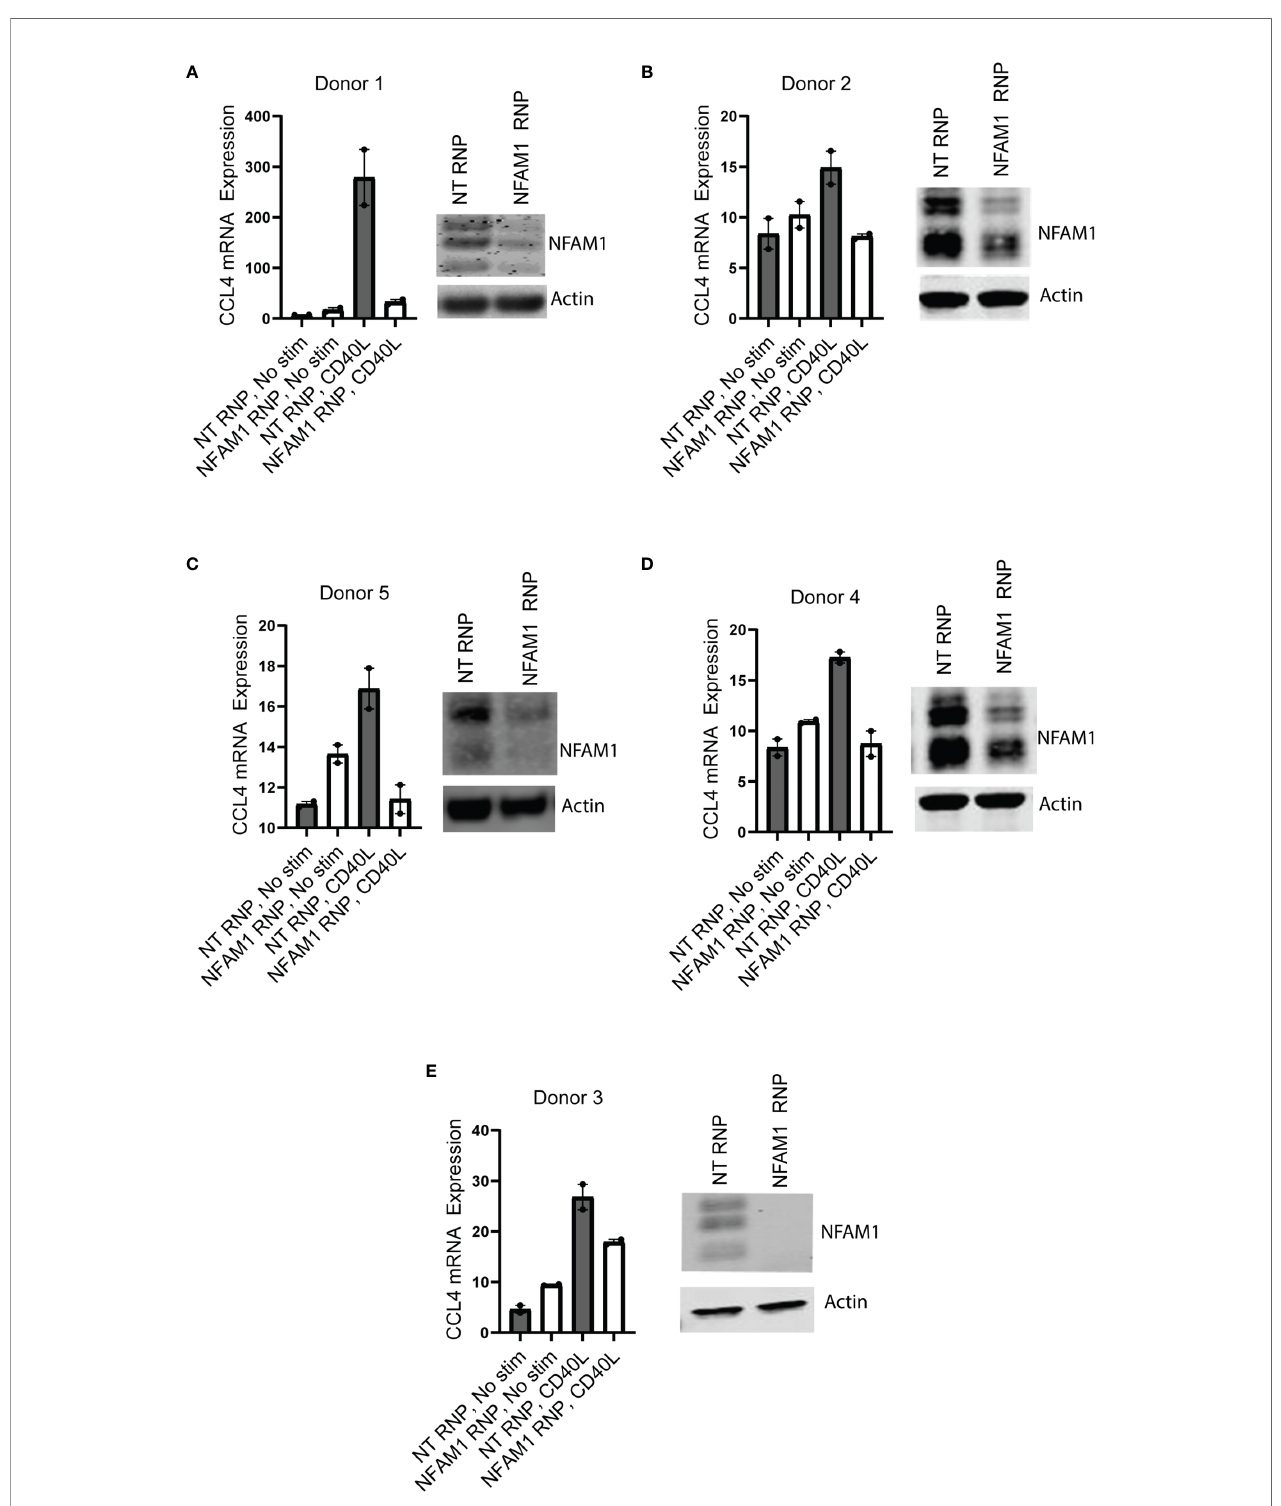
FIGURE 8 | NFAM1 promotes CD40L-induced CCL4 production in human monocytes. (A – E) Human monocytes were isolated from 5 independent donors and treated with Non-targeting (NT) CRISPR-RNP or NFAM1 CRISPR-RNP. Cells were plated in duplicate and stimulated with CD40L. Shown are NFAM1 protein expression and CCL4 mRNA